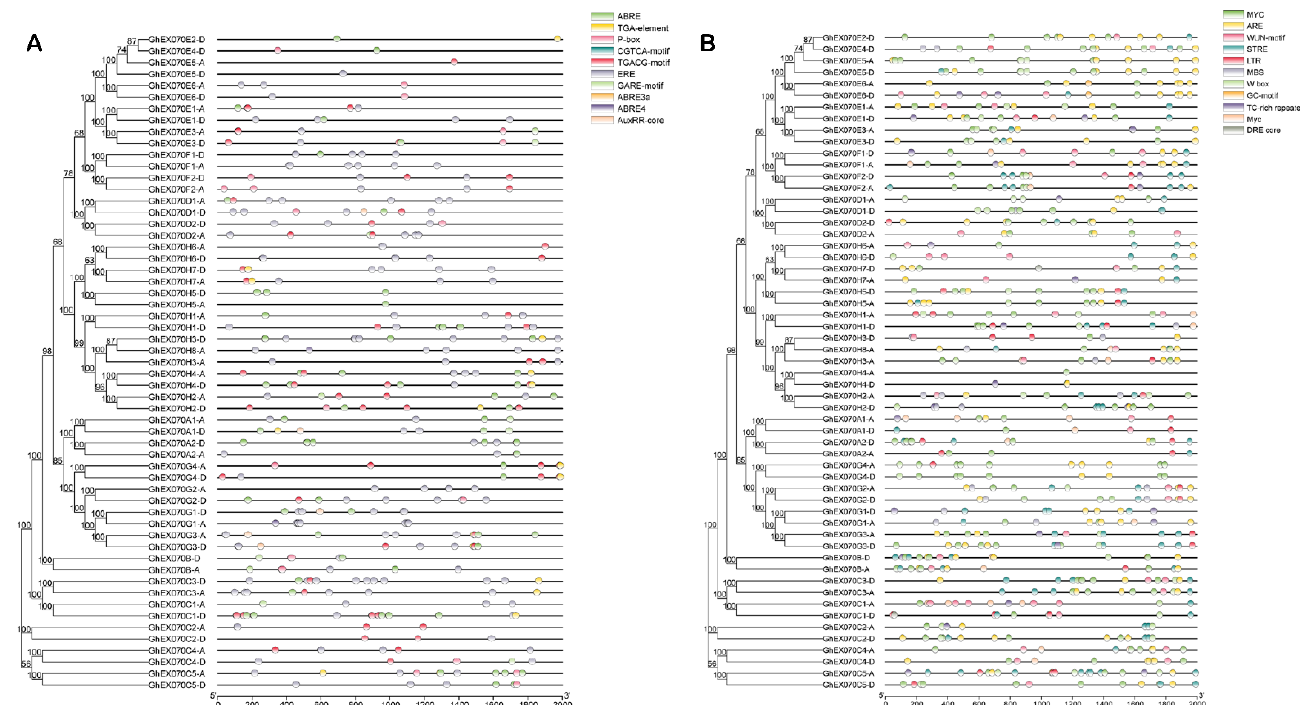
Figure 5. Cis -acting elements in GhEXO70 promoter. ( A ) Cis -elements involved in phytohormones were predicted. ABRE: cis -acting regulatory element involved in abscisic acid response. AuxRR-core: cis -acting regulatory element involved in auxin response. CGTCA-motif: cis -acting regulatory element involved in methyl jasmonate (MeJA) response. GARE-motif: gibberellin response element. TGACG-motif: cis -acting regulatory element involved in MeJA response. TGA-element: auxin response element. ERE: cis -acting ethylene response element. P-box: gibberellin response element. ( B ) Predicted cis -elements involved in environmental stress response. GC-motif: enhancer-like elements involved in specific hypoxia induction. LTR: cis -acting elements involved in low temperature response. MBS: MYB binding sites related to drought induction. STRE: stress response elements. TC-rich repetitive sequences: cis -acting elements involved in defense and stress responses. WUN-motif: wound response elements. MYC: cis -acting elements involved in drought stress. W box: cis -acting elements involved in sugar metabolism and plant defense signals. DRE core: dehydration response element. ARE: cis -acting regulatory element for anaerobic